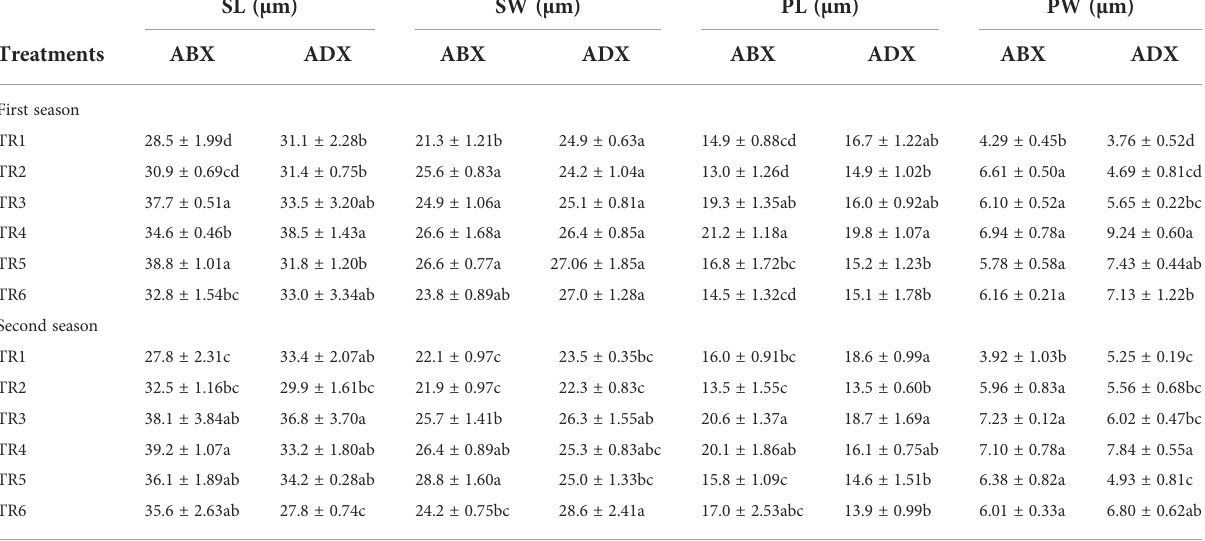
TABLE 3 Effect of different treatments on stomatal dimensions of abaxial and adaxial surface of C. sativum under drought regimes in the fi rst and second seasons.